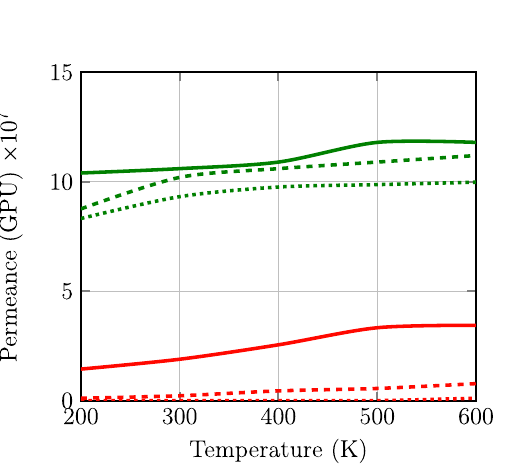
Figure 7. Permeance of H 2 and CO 2 gases passing through the GDY-H membrane in our proposed approach as a function of temperature based on MD simulations. The green and red plots represent the permeances of H 2 and CO 2 gases, respectively. The fill plot, dashed plot and dotted plot represent the monolayer, two layers and two layers of the membrane in the presence of 1,3,5-TAB, respectively. 1 GPU=3.35